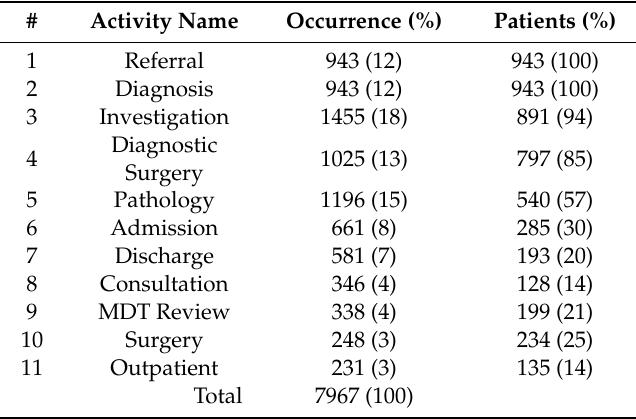
Table 3. The activity